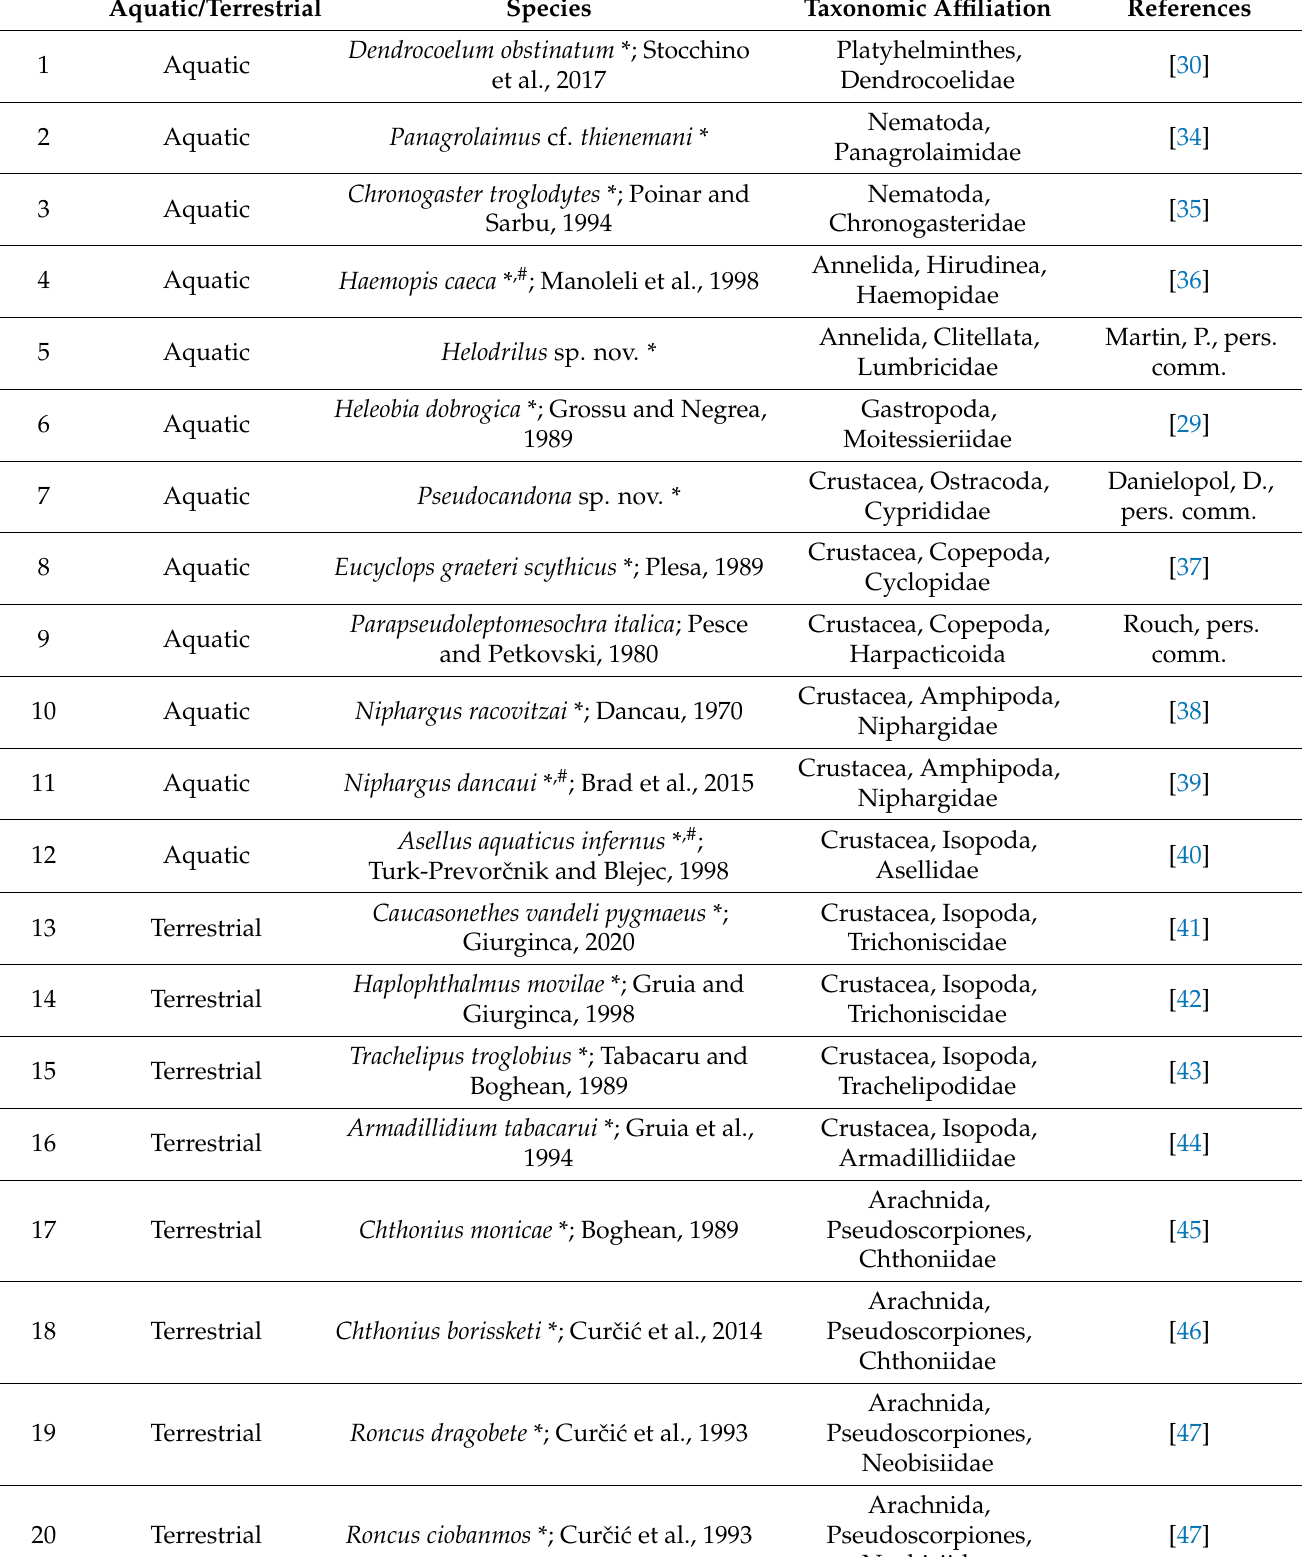
Table 2. List of troglobionts and stygobionts from Movile